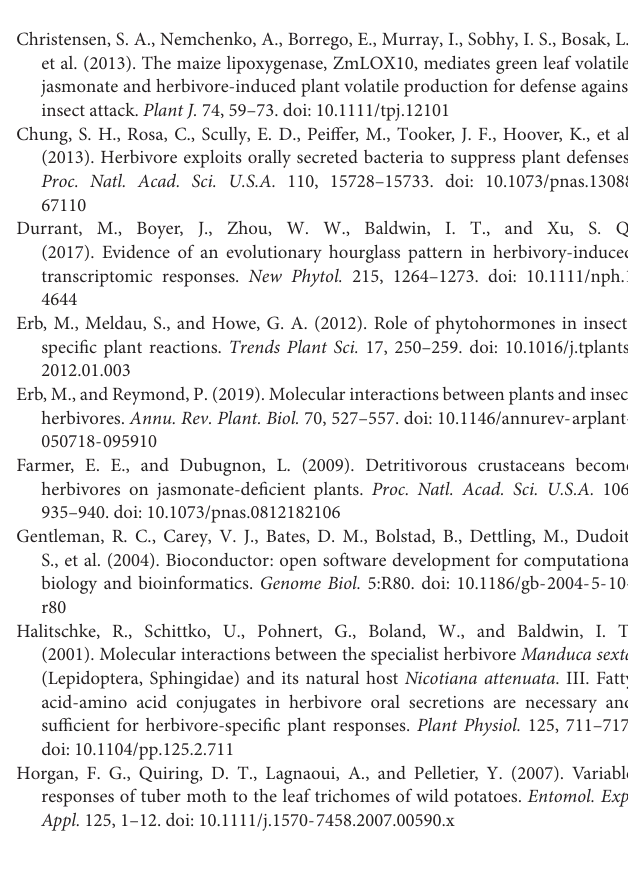
Supplementary Figure 6 | Temporal dynamic of phytohormones in potato plants after simulated herbivory. Four phytohormones JA (A) , JA-Ile (B) , ABA (C) , and SA (D) were measured at 0, 0.5, 1, and 3 h (mean ± SE, n = 5). Asterisks indicate significant differences between treatment and control (Student’s t -test, ∗ p < 0.05, ∗∗ p < 0.01, and ∗∗∗ p < 0.001). Supplementary Figure 7 | Phytohormonal responses were not affected by antibiotic cocktail at 1 h after elicitation. Four phytohormone JA (A) , JA-Ile (B) , ABA (C) , and SA (D) were measured at 1 h after W + W (wounding + water), W + AB diluent (wounding + antibiotic cocktail 1:5 diluent), and W + AB (wounding + antibiotic cocktail). One-way ANOVA results for each phytohormone are shown (ns, not significant). Supplementary Table 1 | The primers for qRT-PCR in this study. Supplementary Datasheet 1 | Gene information of each gene